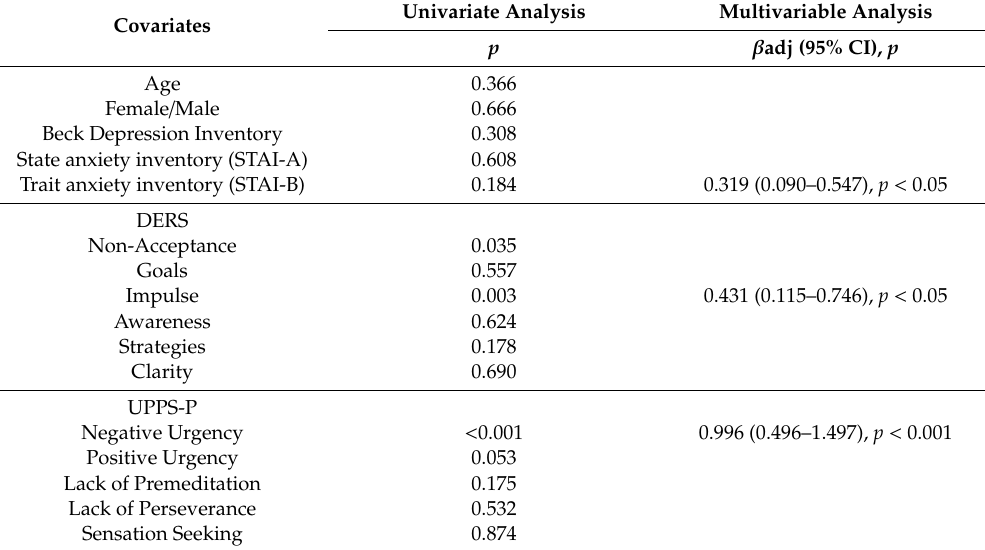
Table 4. Multiple linear regression analysis of the association between DEBQ subscale (External eating) and sociodemographic and clinical characteristics in the BED